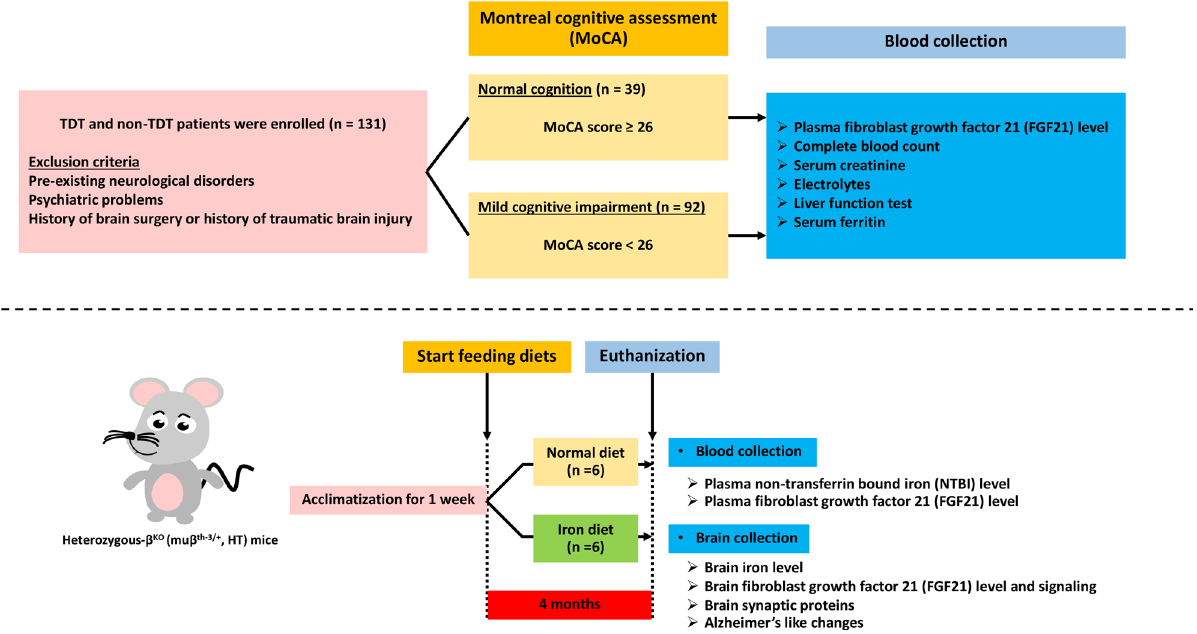
Figure 4. Summarized experimental protocol for clinical and in vivo studies. TDT transfusion-dependent